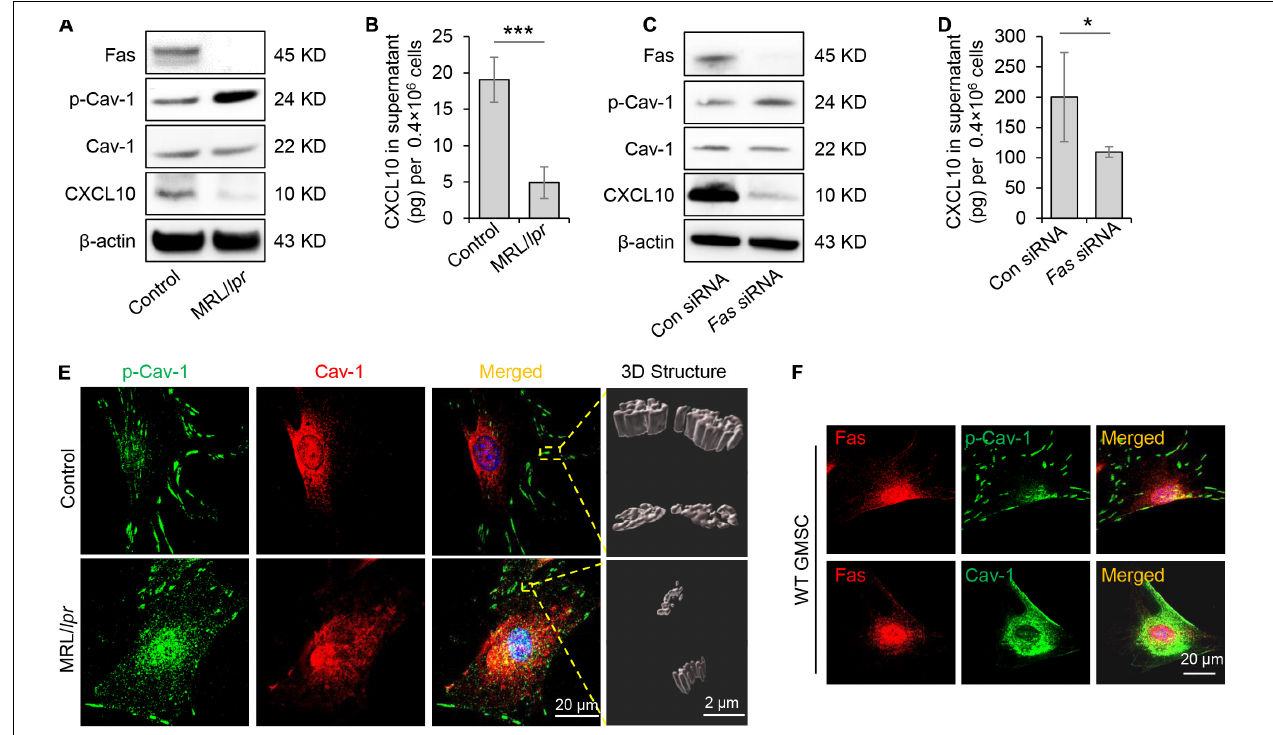
FIGURE 4 | Fas controlled dephosphorylation of Cav-1 and CXCL10 release in murine GMSCs. (A) Western blotting analysis of p-Cav-1, Cav-1, and CXCL10 in GMSCs from Fas -deficient MRL/ lpr mice. (B) Knocking out of Fas down-regulated CXCL10 secretion in GMSCs culture supernatant as analyzed by ELISA. *** P < 0.001 compared with WT GMSCs control. (C) Western blotting analysis confirmed the efficiency of Fas siRNA, and showed that knocking down of Fas up-regulated p-Cav-1 expression and reduced cytoplasmic CXCL10 in GMSCs. (D) Knocking down of Fas decreased CXCL10 secretion in the culture supernatant of GMSCs as analyzed by ELISA. * P < 0.05 compared with GMSCs treated with control siRNA. (E) Higher resolution images of Cav-1 (red) and p-Cav-1 (green) in MSCs captured by SIM microscopy. Scale bar, 20 µ m. Right panel, 3D reconstruction of 2D Z -stack data showed the different steric structures of p-Cav-1 in GMSCs and MRL/ Lpr GMSCs. Scale bar, 2 µ m. (F) Immunocytofluorescence staining images of p-Cav-1, Cav-1, (green) and Fas (red) in GMSCs. Scale bar, 20 µ m. All results are representative of data generated in at least three independent experiments. Error bars are means ± SD. Data were analyzed using independent unpaired two-tailed Student’s t